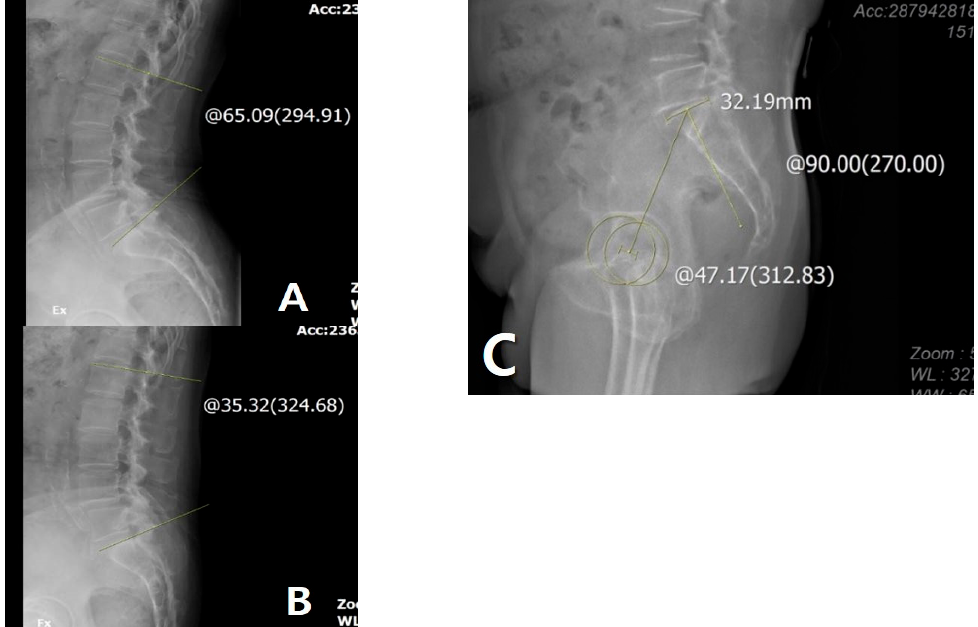
Figure 2. ( A ) Measurement of lumbar lordosis (LL) on extension view: 65.09°. ( B ) Measurement of LL on flexion view: 35.32°. ( C ) Measurement of pelvic incidence: 47.17°. The yellow line and circle are